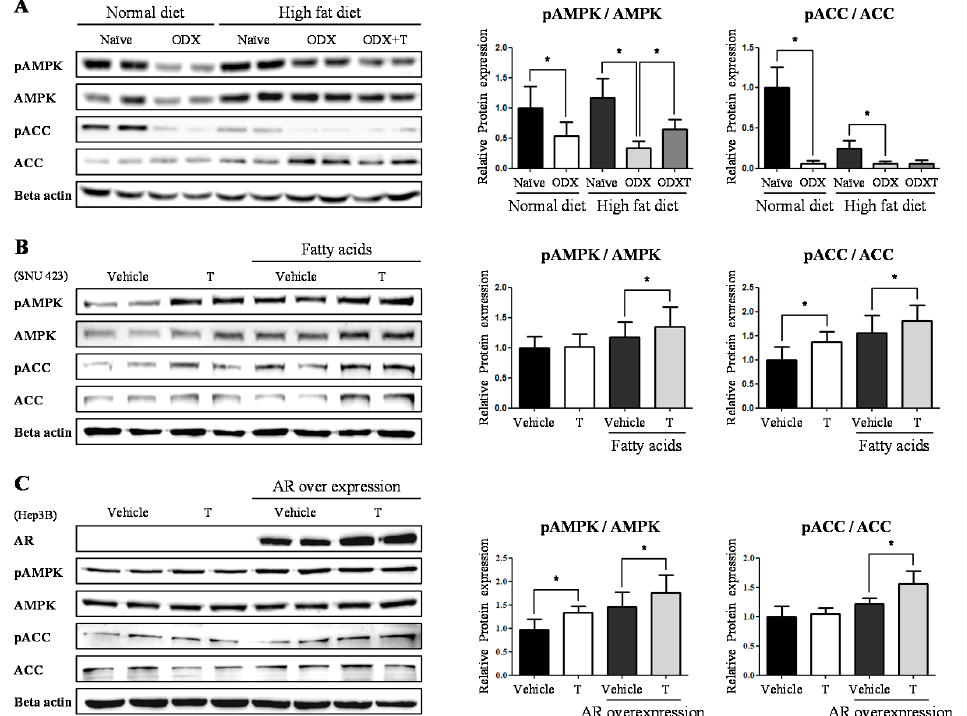
Figure 3. When androgens are sufficient, AMPK-ACC signaling is phosphorylated. ( A ) The protein level was determined by Western blotting of male mice livers. The quantification was arranged as the ratio of phosphorylated form and total form, in AMPK and ACC. Beta-actin (Rabbit) was used as an internal control. ( B ) The proteins level was determined by Western blotting, with SNU-423 cells supplemented with fatty acids (Palmitate 330 µM, Oleate 660 µM). Testosterone (T) (10 nM) was treated and incubated for 6 h. The quantification was arranged as the ratio of phosphorylated form and total form, in AMPK and ACC. Beta-actin (Rabbit) was used as an internal control. ( C ) The proteins level was determined by Western blotting, with Hep3B cells after overexpressed to AR . Testosterone (T) (10 nM) was treated and incubated for 6 h. The quantification was arranged as the ratio of phosphorylated form and total form, in AMPK and ACC. Beta-actin (Rabbit) was used as an internal control. The values stand for means +/ − S.D. * p < 0.05 was compared to groups indicated.